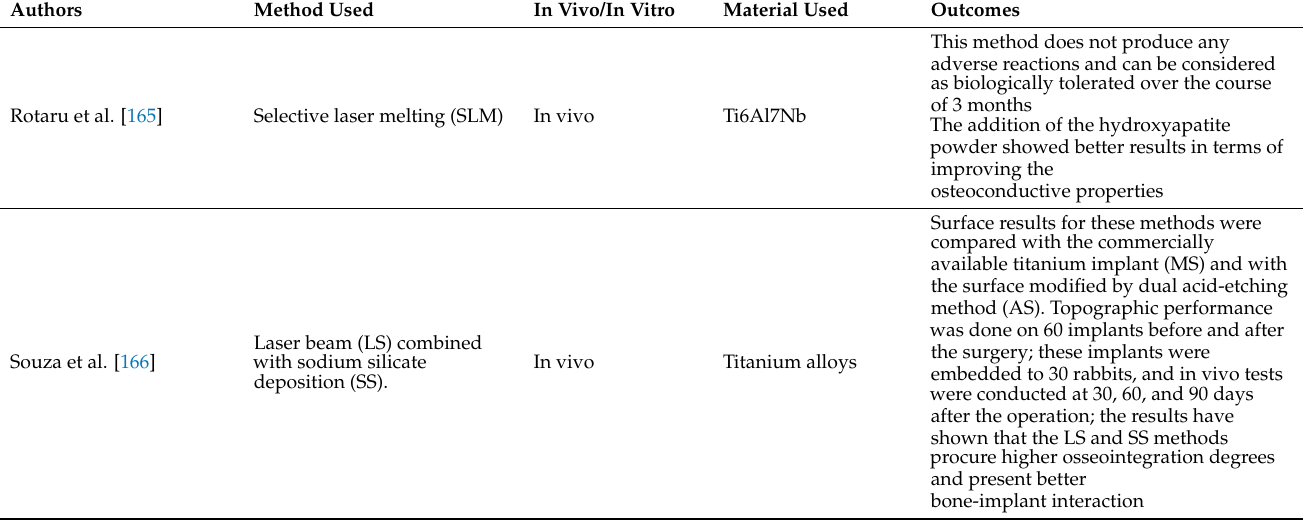
Table 11. In vivo/in vitro experiments conducted with laser surface modification techniques for biomedical